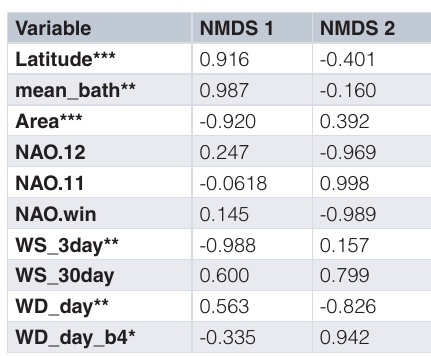
Table 3. Results of final NMDS.